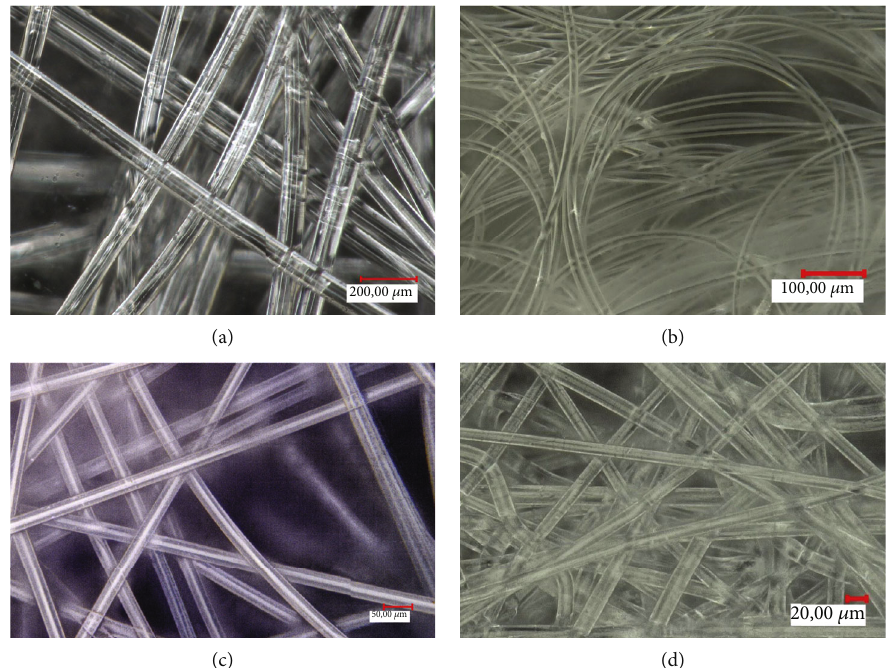
Figure 5: Microscope images of PMMA 6 N (a) and PP HP561R (b) (modi fi ed capillary rheometer) as well as PET RT20 (c) (spunbond) and PP HL 712 FB (d) (meltblown) fi bres.